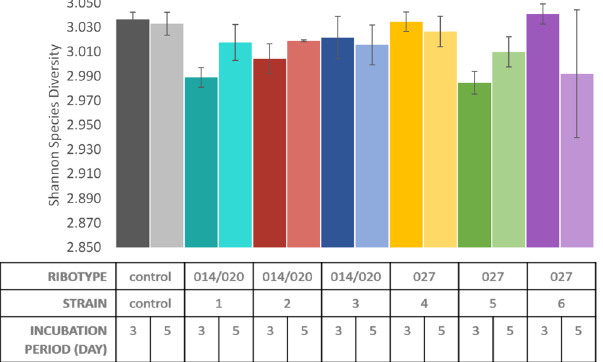
Figure 1. Species diversity (Shannon index with corresponding standard deviation) in WCAB (Wilkins Chalgren Anaerobe Broth) control medium and in WCAB conditioned medium of six different C. difficile strains (1–6), belonging to two different ribotypes (014/020, 027) on day 3 and day